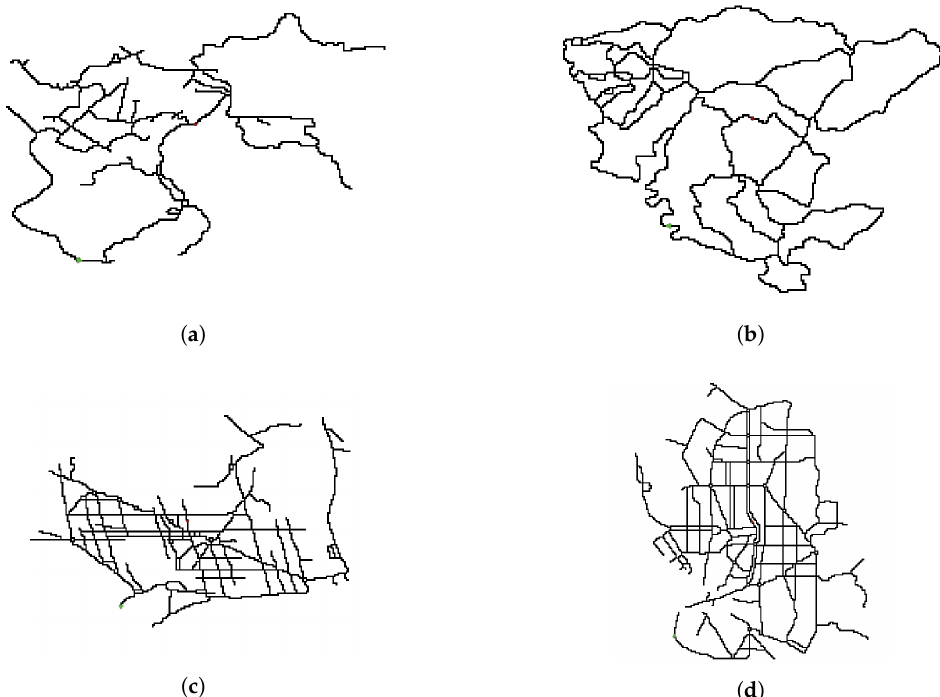
Figure 5. Topologies and spatial complexities for: ( a ) Gijón R = 0.0384; ( b ) Castellón R = 0.0565; ( c ) Barcelona R = 0.0573; and ( d ) Madrid R =